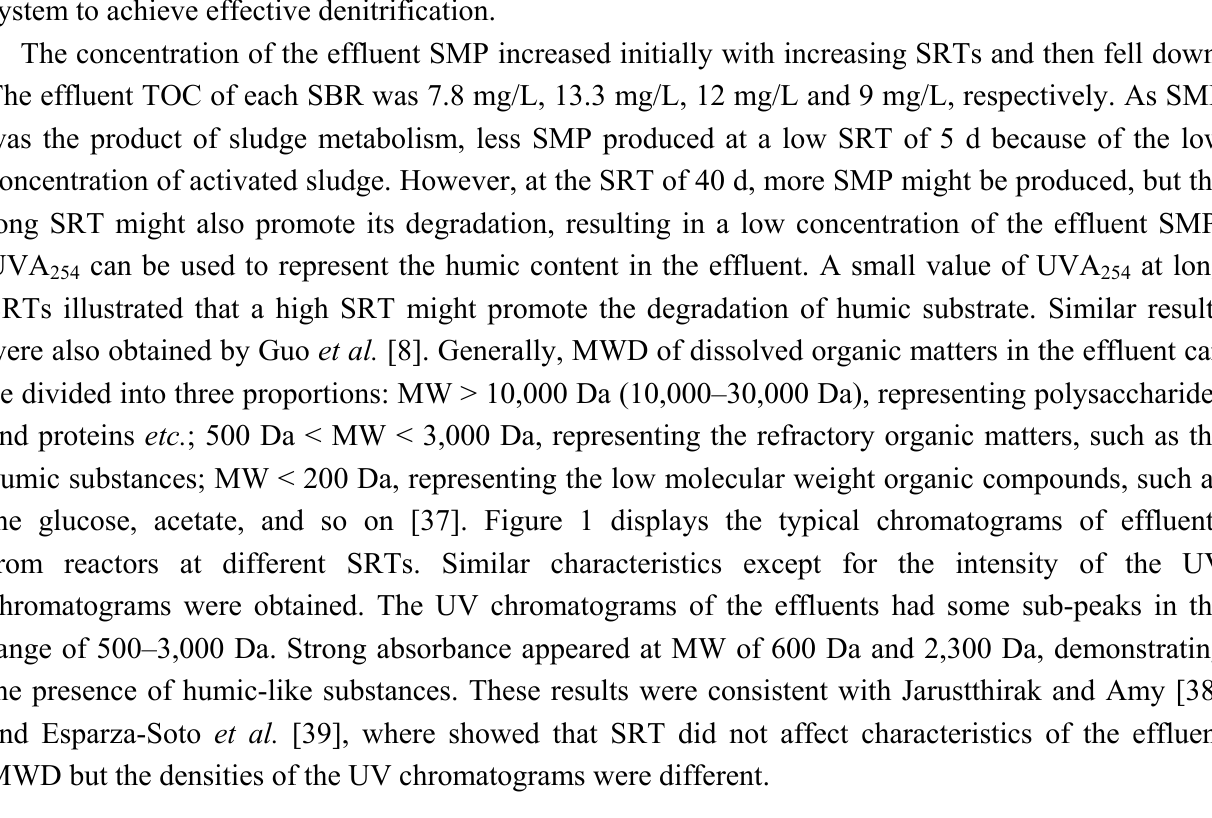
Figure 1. The molecular weight distribution of organic matters in the effluent of SBRs at different